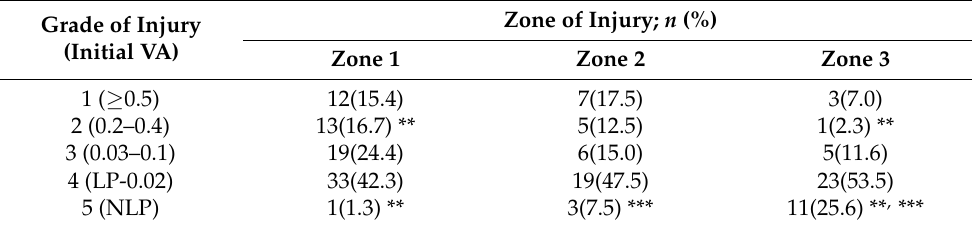
Table 4. Distribution by zone and grade of open globe injury.